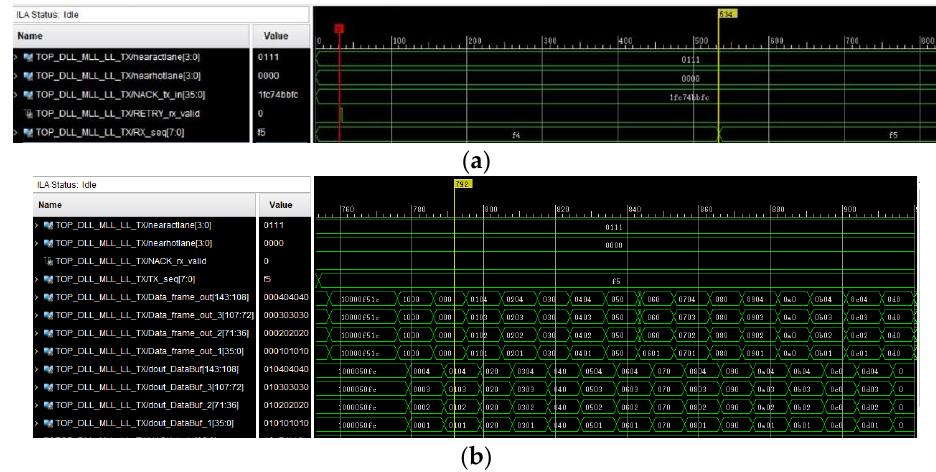
Figure 11. The ILA waveforms of hierarchical error recovery. ( a ) Far end; ( b ) near end.